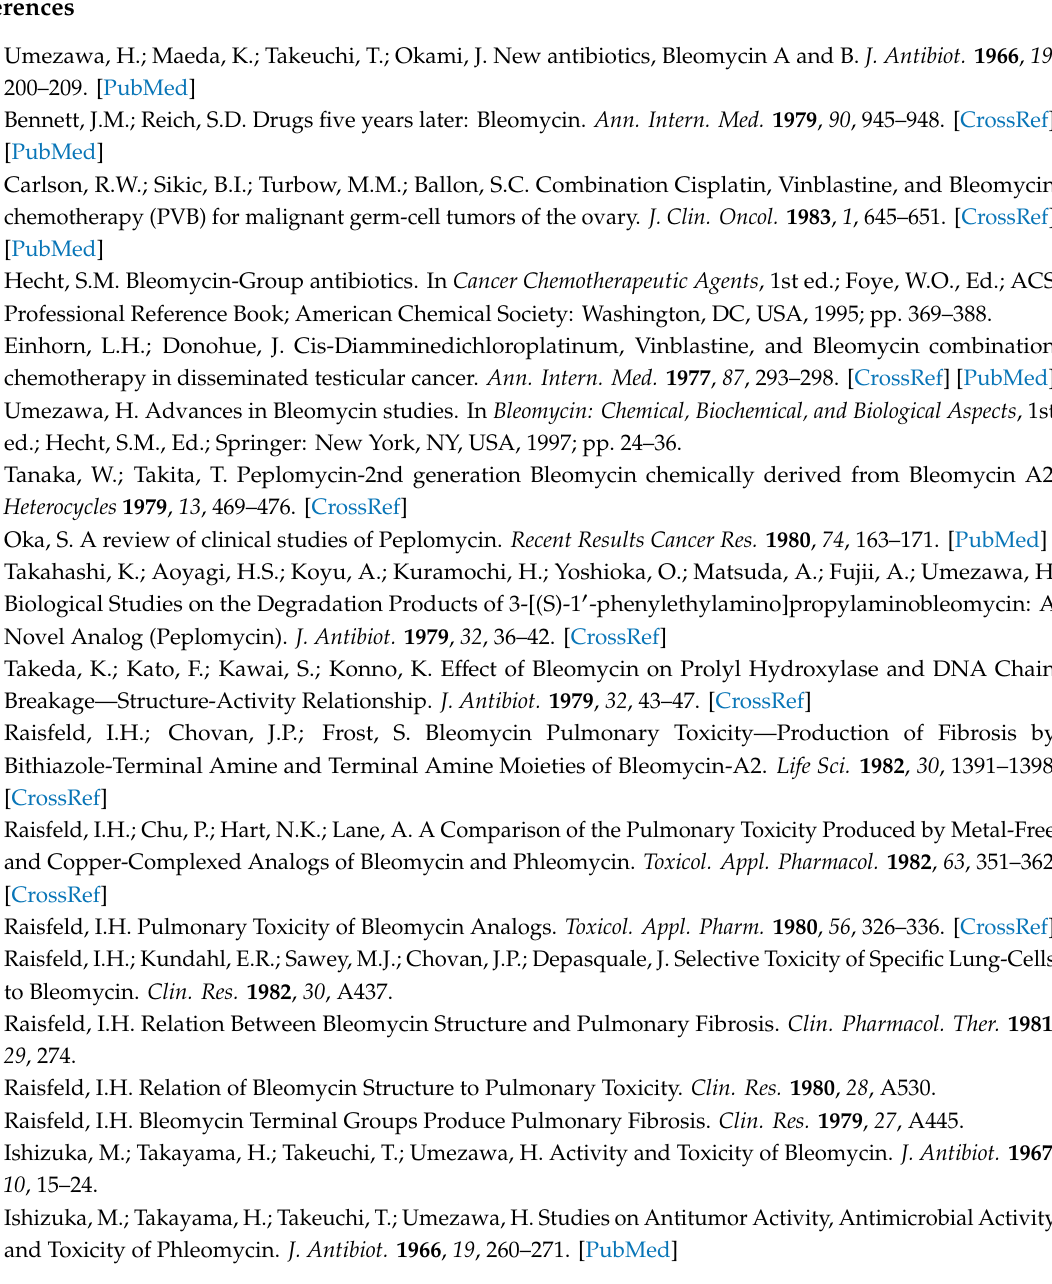
Figure S1: NOESY spectrum of free OL 2 in D 2 O collected at 25 ◦ C, Table S1: NOESY connectivities displayed by OL 2 in H 2 O at 5 ◦ C, Table S2: Inter-base NOE connections detected in D 2 O at 25 ◦ C for free and MBLM-bound OL 2